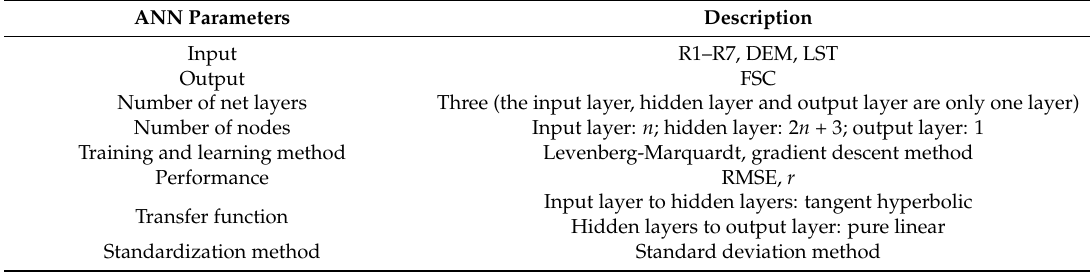
Table 2. Information on the parameters of the BP-ANN